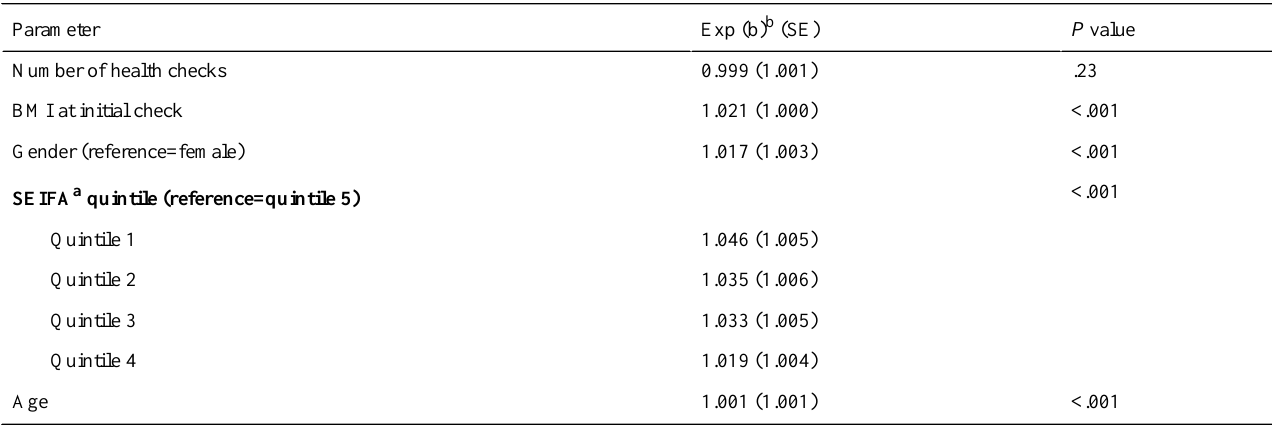
Table 6. Generalized linear model explaining the effect of number of health checks on BMI at final